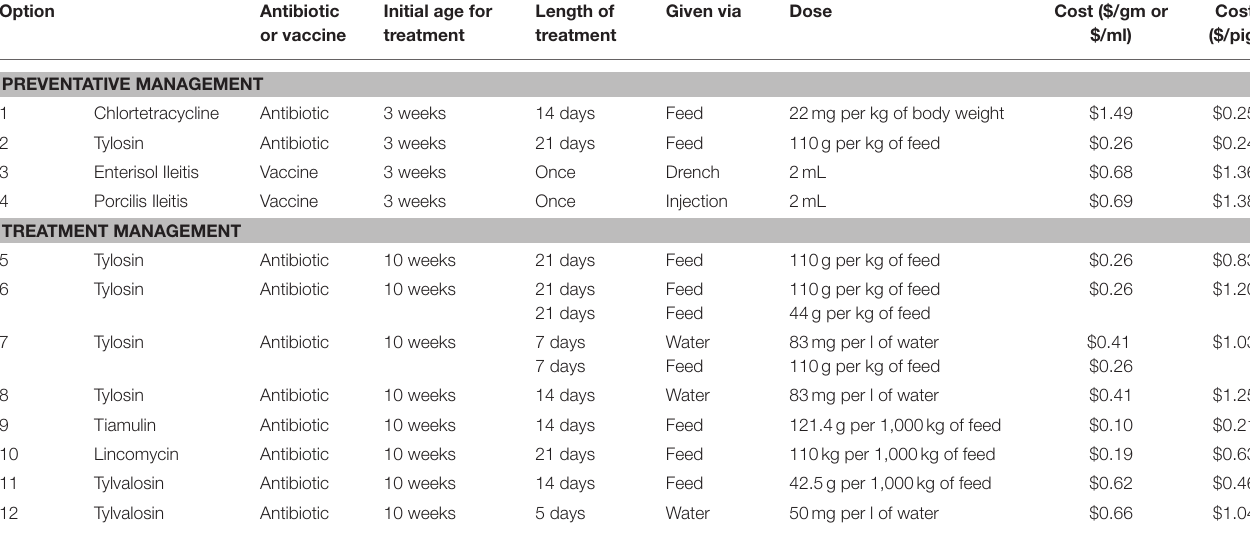
TABLE 4 | L. intracellularis management strategies listed in the Canadian compendium of veterinary